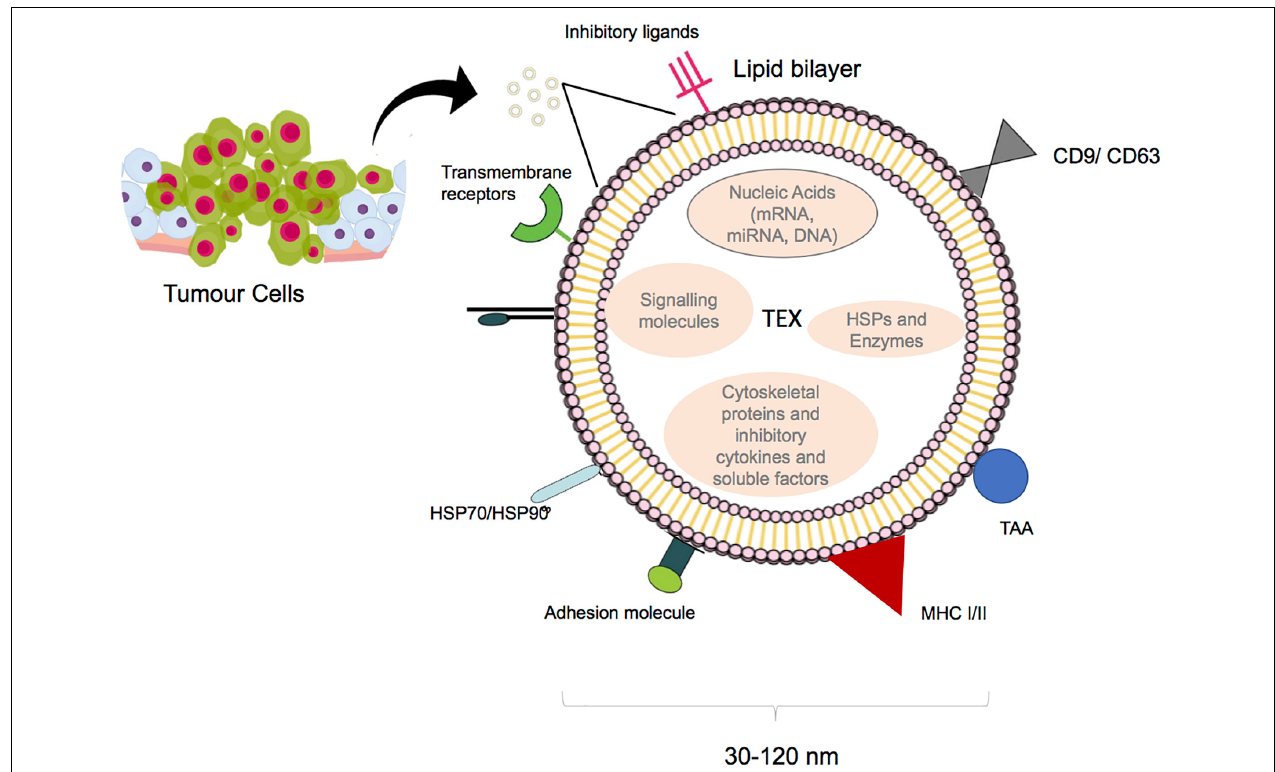
FIGURE 1 | Structure of tumor derived exosome. Size and composition of TEXs. Image designed by Adeleh